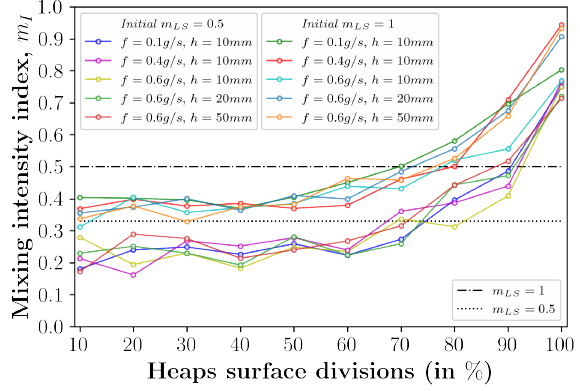
Figure 3. Mixing state computation across 2D granular deposits, heaps are divided in ten vertical stripes of same surface along its length. m I gradations corresponding to mixtures initial m LS are indicated as horizontal thresholds.